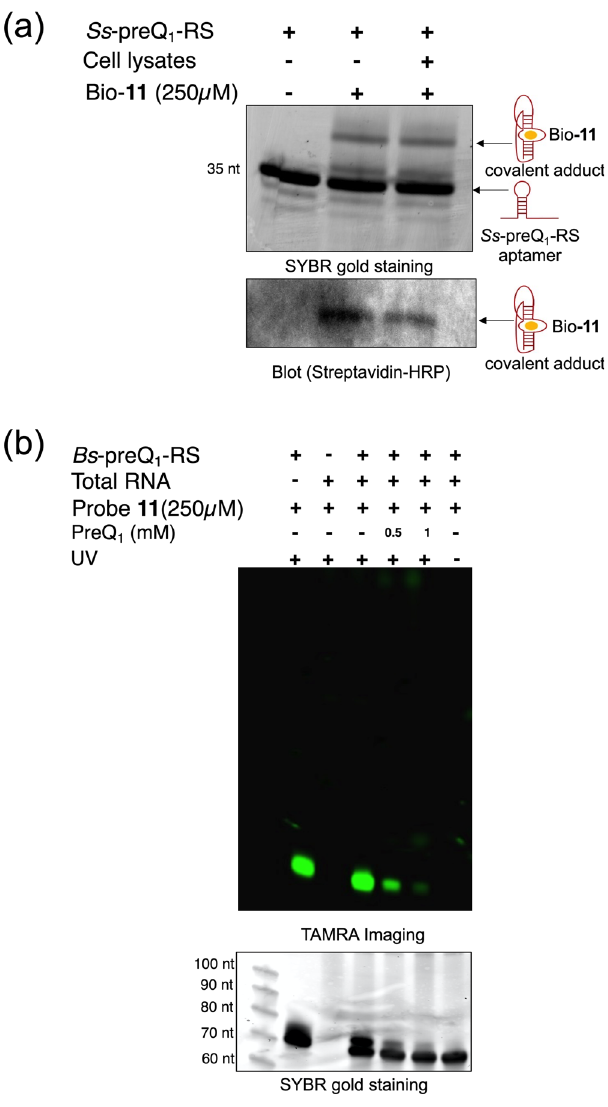
1 -RS aptamer in the presence of cell lysates. The crosslinked